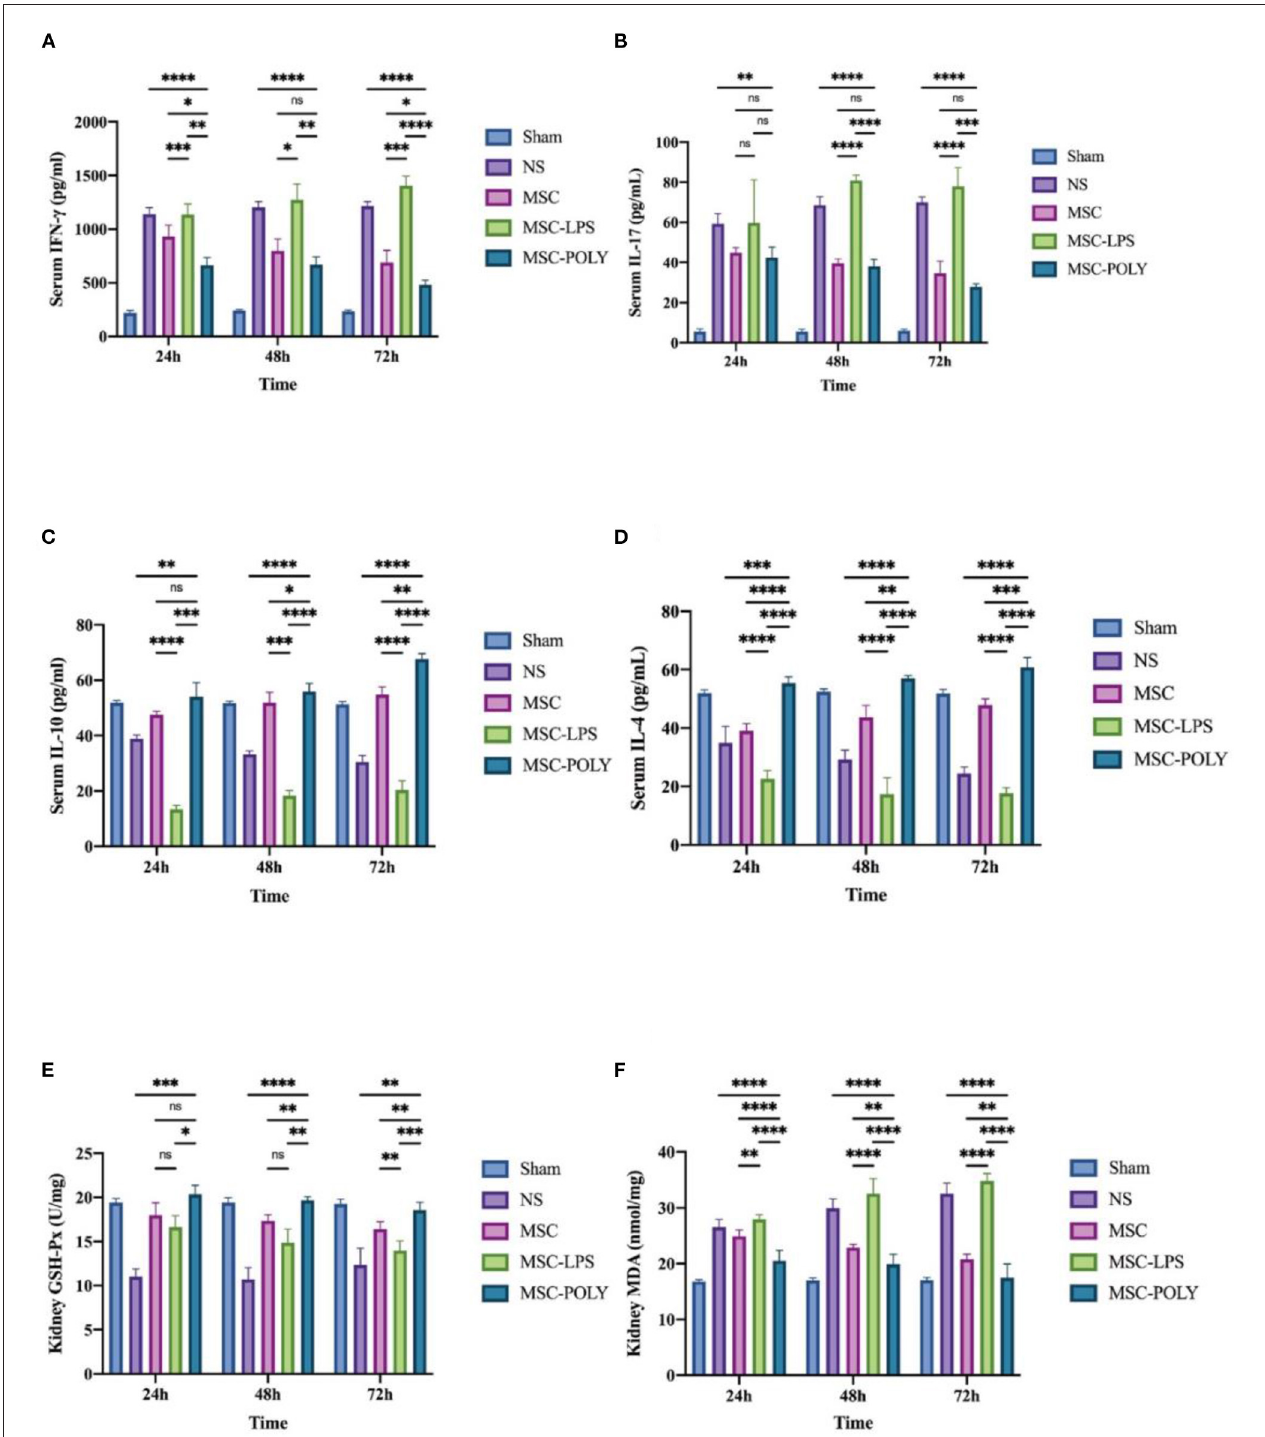
FIGURE 4 | Determination of serum circulating inflammatory factors and renal glutathione peroxidase and malondialdehyde contents of mice treated with different mesenchymal stem cell subsets. (A) Serum IFN- γ content of mice at three time points after sham operation (Sham), treatment with normal saline (NS), untreated mesenchymal stem cells (MSC), mesenchymal stem cells treated with 10 µ g/mL LPS (MSC-LPS), and mesenchymal stem cells treated with 1 mg/mL poly(I:C) (MSC-POLY), respectively. (B) Serum IL-17 contents of mice of mice at three time points of five groups. (C) Serum IL-10 content of mice at three time points of five groups. (D) Serum IL-4 contents of mice at three time points of five groups. (E) Kidney glutathione peroxidase content of mice at three time points of five groups. (F) Kidney malondialdehyde content of mice at three time points of five groups. Values were expressed as mean ± standard deviation (mean ± SD), n = 6, ns = not statistically significant, * P < 0.05, ** P < 0.01, *** P < 0.001, **** P < 0.0001.